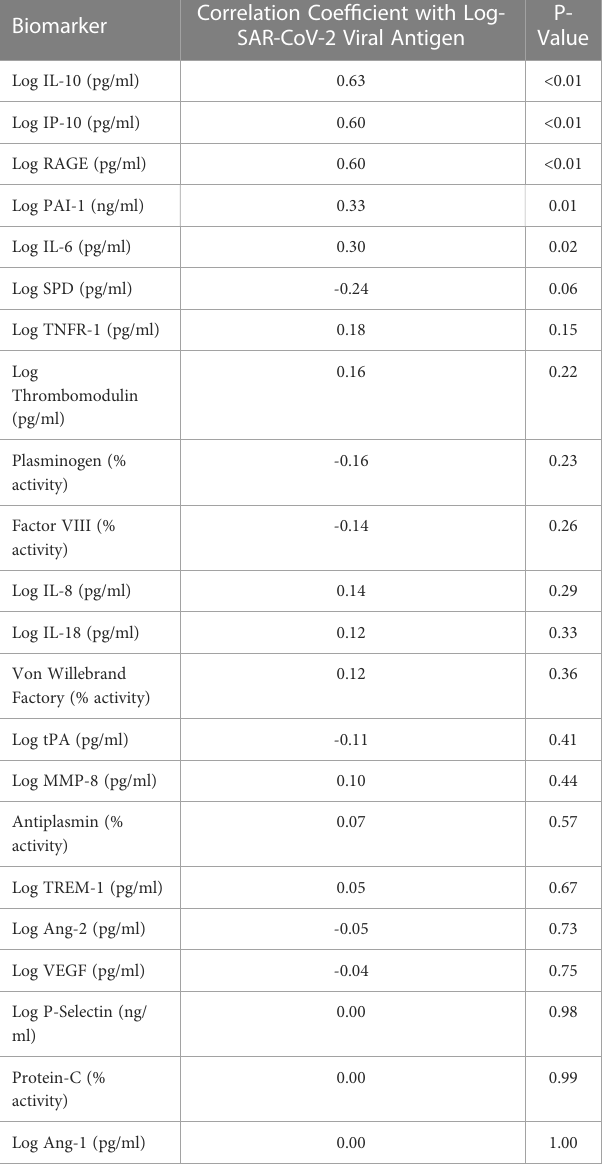
TABLE 5 Spearman correlation coef fi cients of thromboin fl ammatory biomarkers with SARS-COV-2 nucleocapsid viral